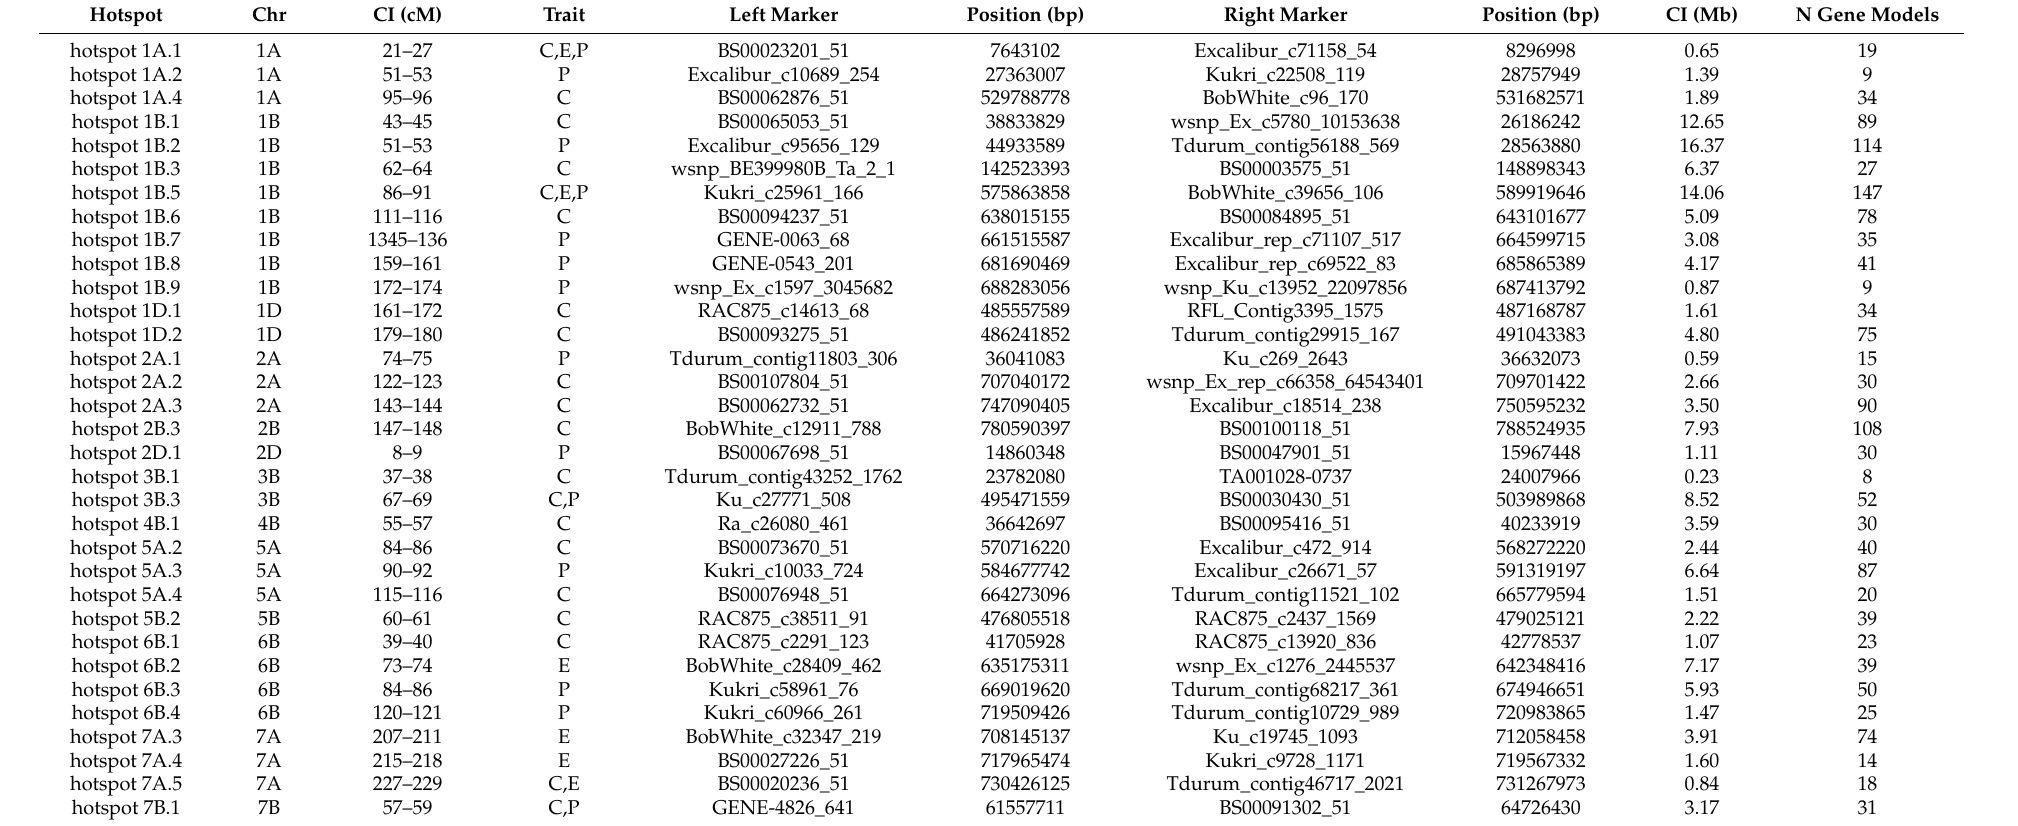
Table 3. Selected QTL hotspots. Chr, chromosome; C, climatic trait; E, eigen vectors; P, phenology